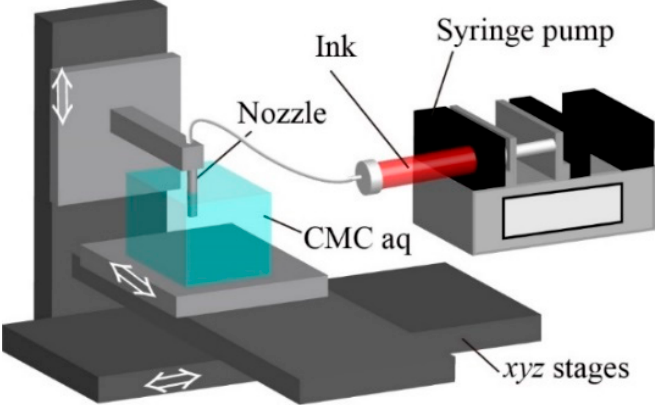
Figure 2. Schematic of setup. A nozzle is fixed on a z stage, and a container of carboxymethyl